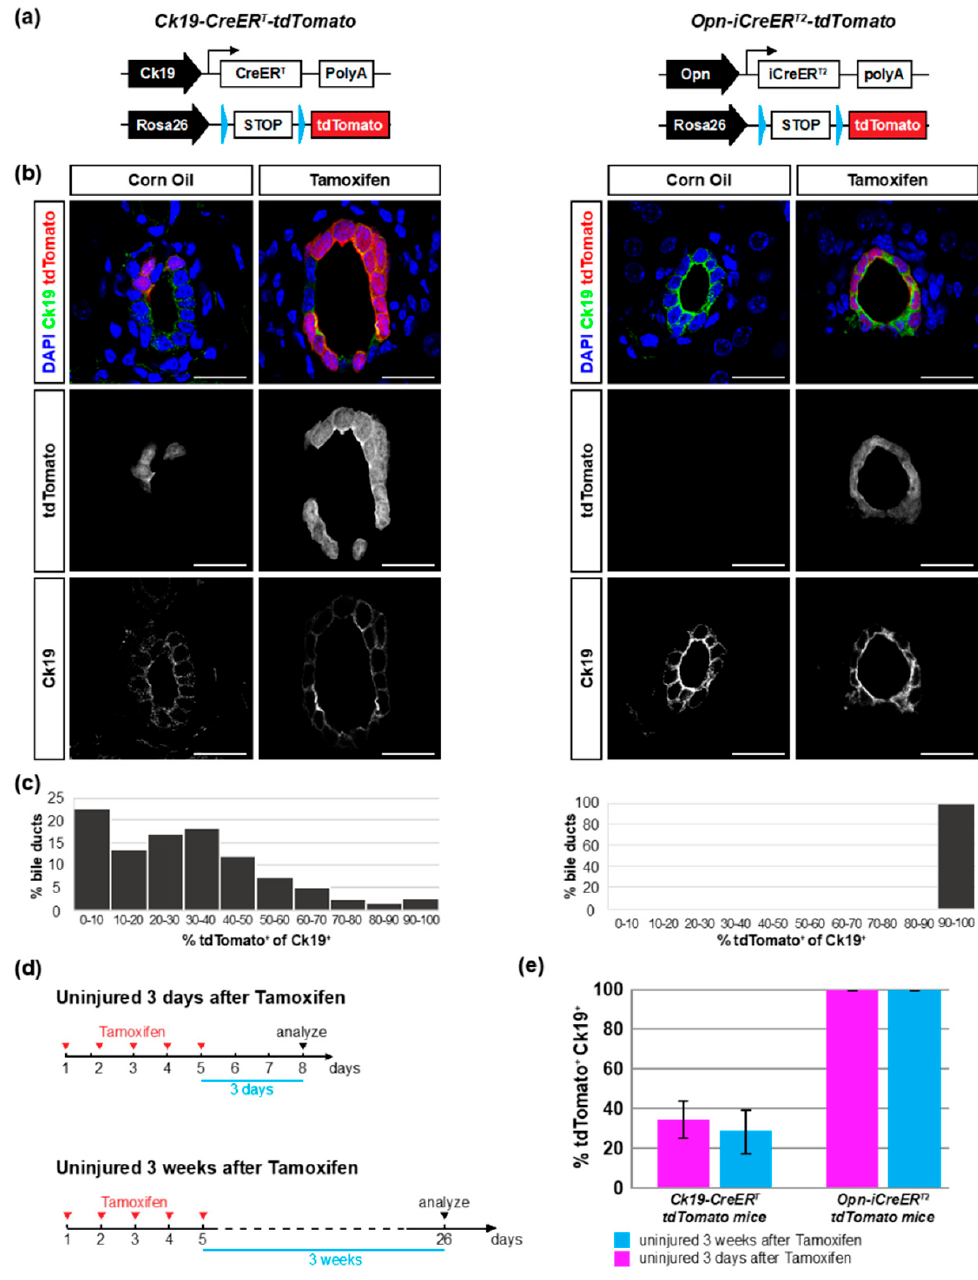
Figure 1. Opn-iCreER T2 drives loxP site recombination more e ffi ciently than Ck19-CreER T . ( a ) Schematic overview of Cre drivers and recombination alleles of Ck19-CreER-tdTomato and Opn-CreER-tdTomato mice. ( b ) Immunofluorescent detection of Ck19 and tdTomato in liver sections of Ck19-CreER-tdTomato and Opn-CreER-tdTomato mice after vehicle or tamoxifen injection. ( c ) Distribution of recombination e ffi ciency in individual bile ducts ranging from 0 to 100 percent. ( d ) Schematic experimental outline. Mice were injected with tamoxifen on five consecutive days and sacrificed three days or three weeks later. ( e ) Percentage of tdTomato + Ck19 + cells quantified in liver sections at di ff erent timepoints after tamoxifen injection ( n = 7–8 mice per experiment; 20 bile duct regions per mouse). The di ff erence between the two genotypes was significant 3 days ( p = 0.001) and 3 weeks ( p = 0.001) after tamoxifen injection. Scale bars: 20 μ m.